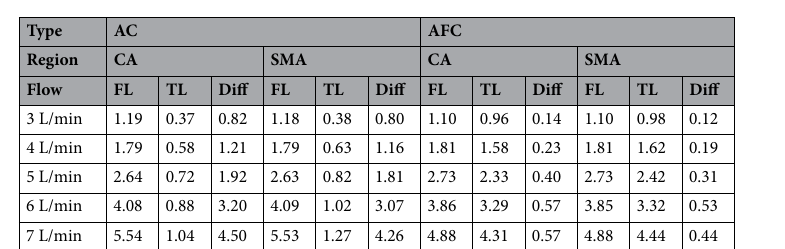
Table 3. Pressure difference between the true and false lumens for AC and AFC in the FSI simulation. AC axillary cannulation, AFC axillary and femoral cannulation, CA celiac artery, FL false lumen, FSI fluid– structure interaction, SMA superior mesenteric artery, TL true